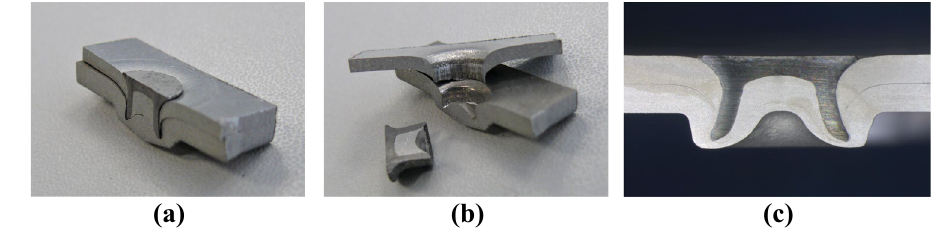
Fig. 1 Cross-sectional views of two different rivets. a Cross- sectioned rivet (composed). b Cross-sectioned rivet (decom- posed). c Close-up of a cross- sectioned